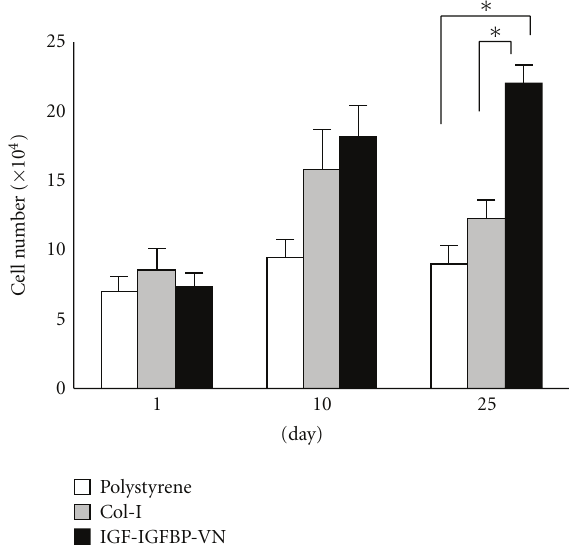
Figure 2: Comparison of the cell proliferation of enamel organ- derived epithelial (EOE) cells on polystyrene, collagen type I, and insulin-like growth factor-I/insulin-like growth factor binding protein-3/vitronectin (IGF-IGFBP-VN) complex at passage 1. The number of cells was counted on days 1, 10, and 25. The growth of EOE cells on IGF-IGFBP-VN complex was faster than that of EOE cells on Col-I. The EOE cells did not grow on PS. Asterisks indicate a significant di ff erence ( P < 0 . 05) between paired conditions.